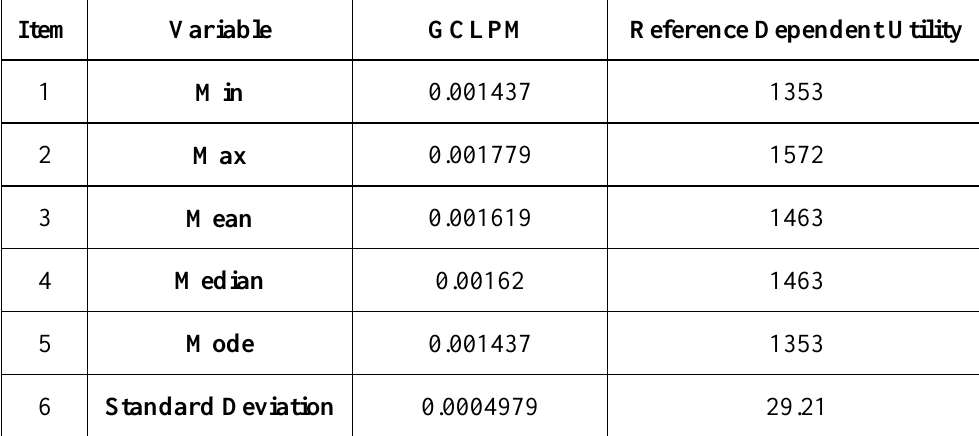
Table 9. Result Specification of Scenario 3 in First